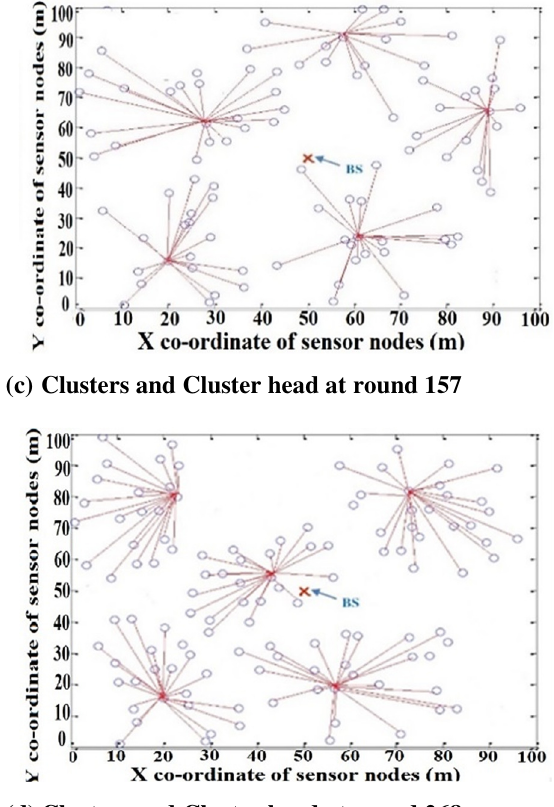
Fig. 11. Clusters and cluster heads at different